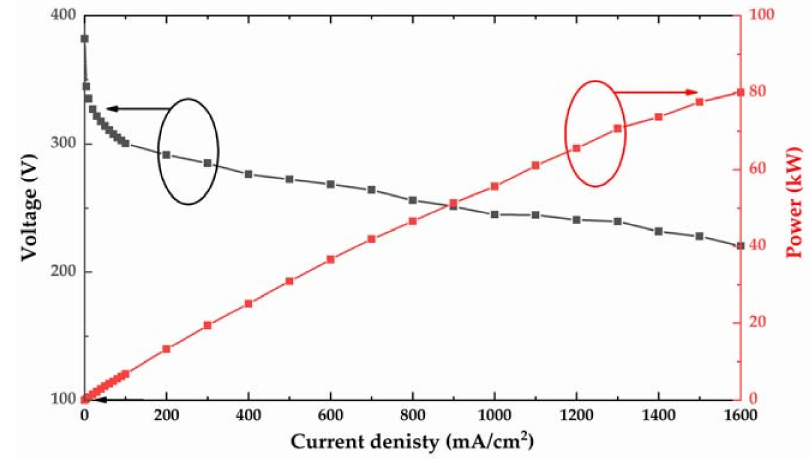
Figure 2. The polarization curve of the fuel cell